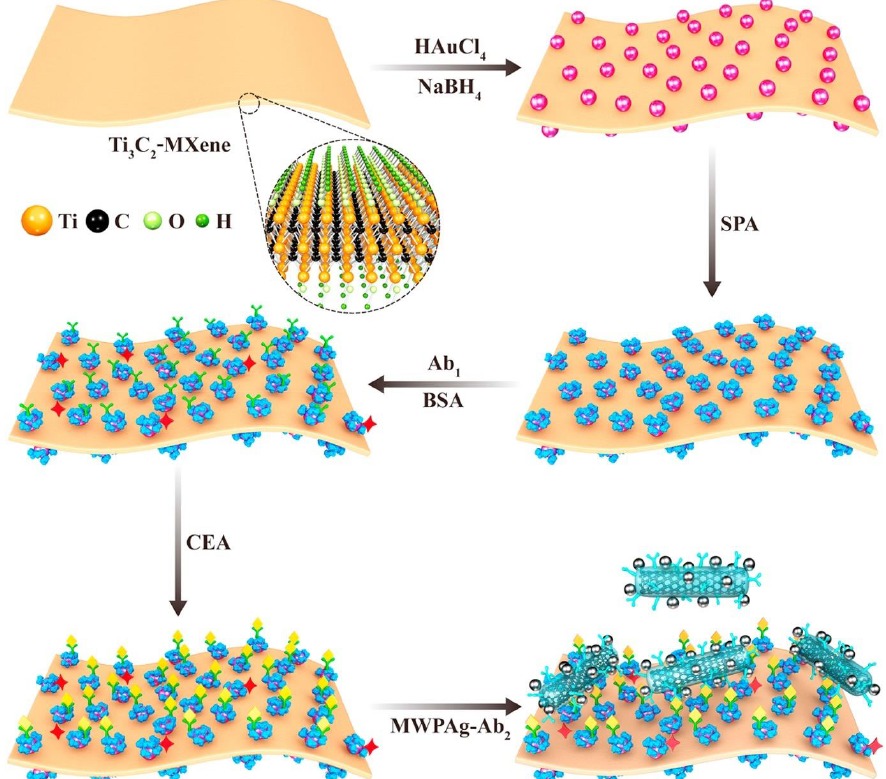
Figure 10. Schematic representation of the modified biosensor for CEA detection. A mixture of Ti 3 C 2 -MXene/AuNPs/SPA-Ab 1 On was prepared on the gold slide. CEA was injected in the following step. MWCNTs-Ab 2 were added to complete the sandwich assay. Reproduced from [101] with permission from Elsevier. Table 1. Design and performance of 2D material multilayer SPR